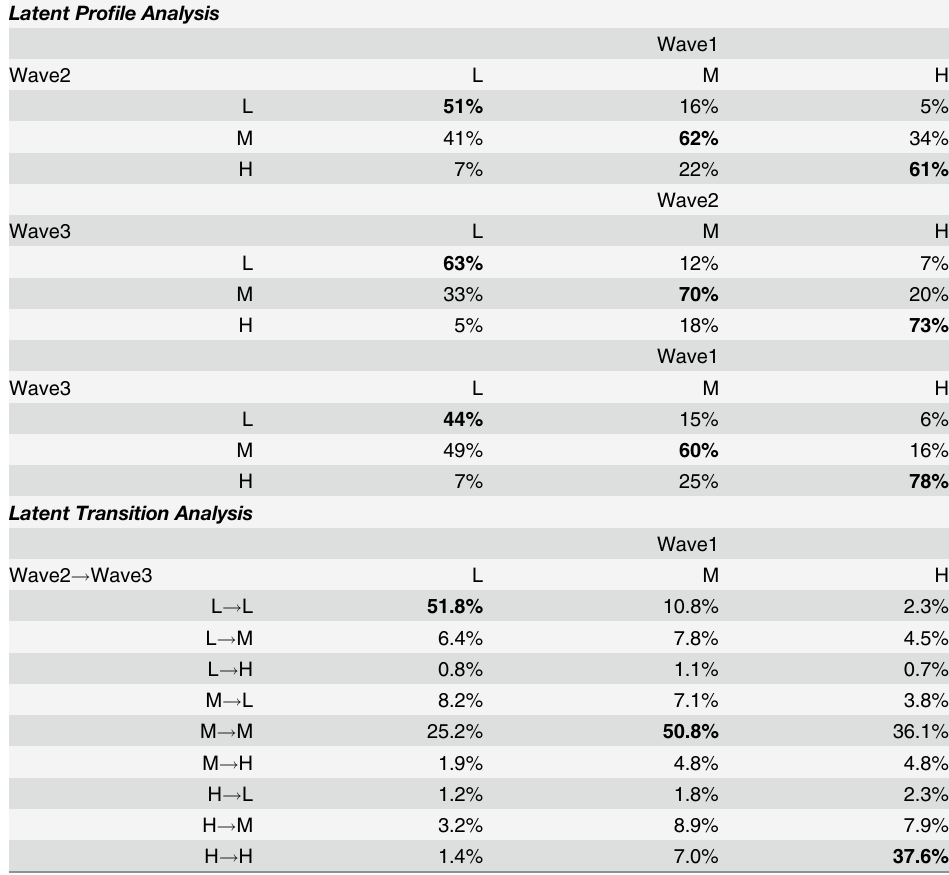
Table 2. Transition Probability for Cohort